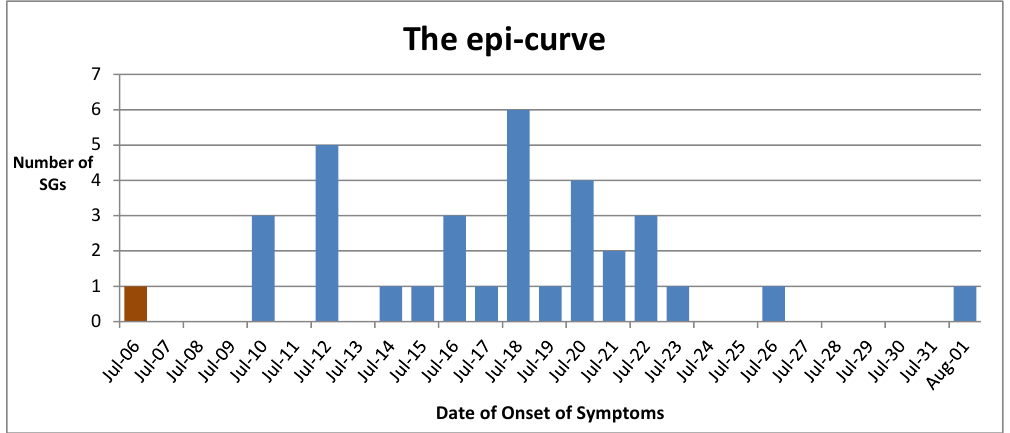
Figure 1. The epi-curve. This depicts the dates of onset of the first symptoms of 34 symptomatic vaccine breakthrough cases and two unvaccinated cases. The index case is shown in maroon color. X-axis: date, Y-axis: the number of SGs who developed their first symptoms. The dates of onset of symptoms of two unvaccinated cases were 16 and 20 July.